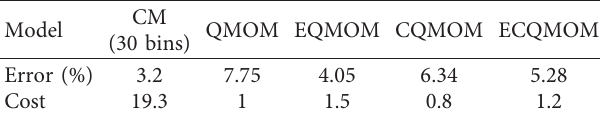
Table 5: Computational time and error of simulation in different models.